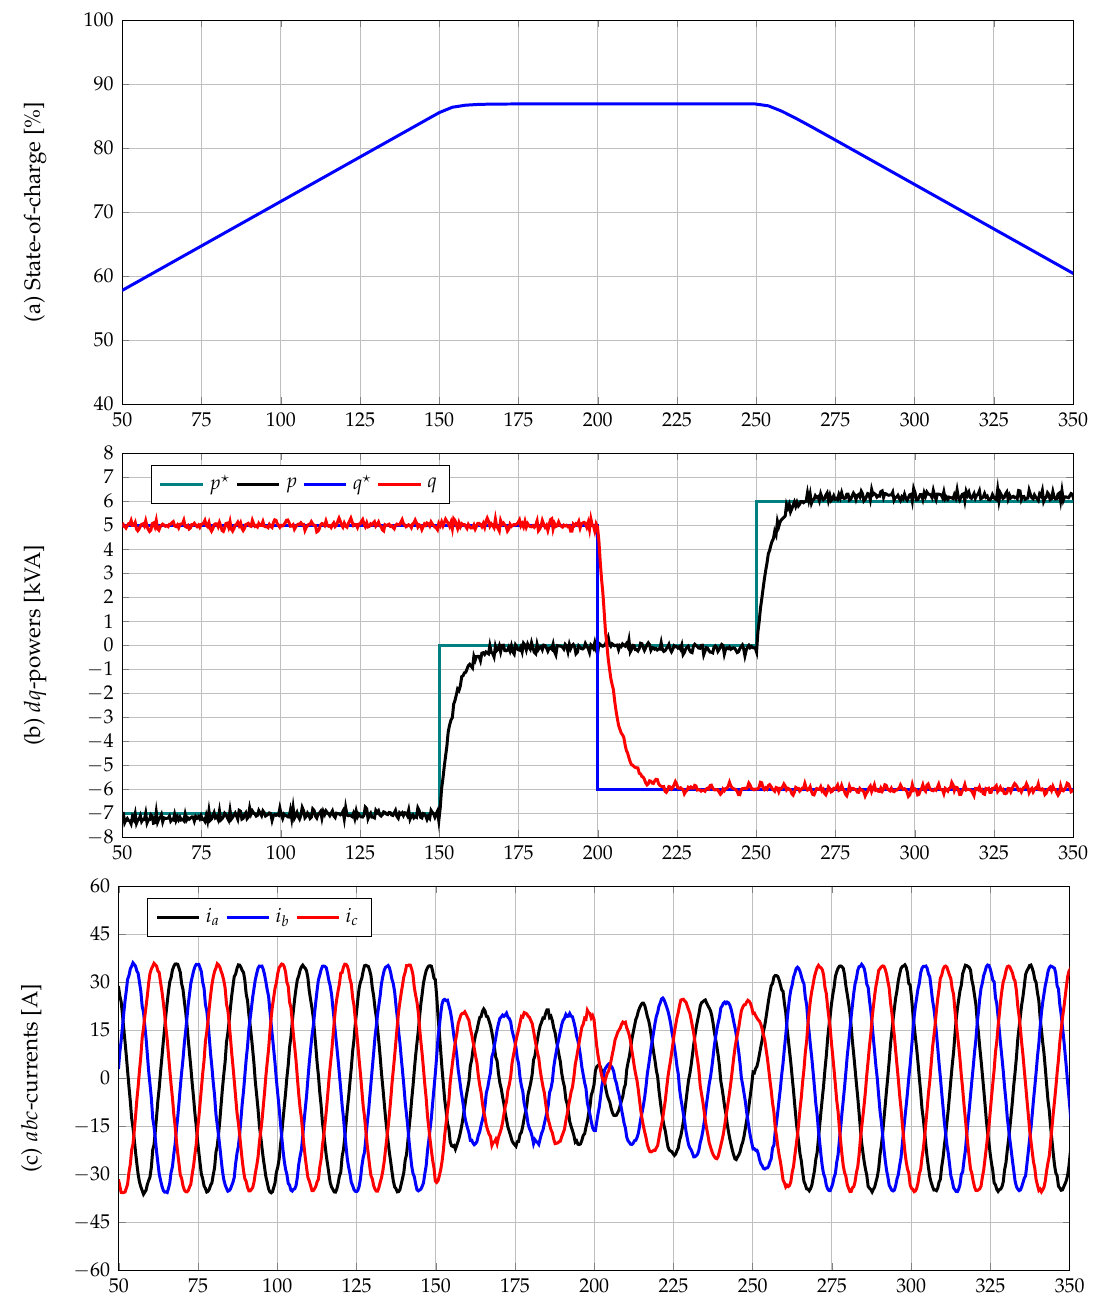
Figure 2. Independent active and reactive power control: ( a ) state-of-charge behavior, ( b ) active and reactive power in the dq − reference frame, and ( c ) three-phase